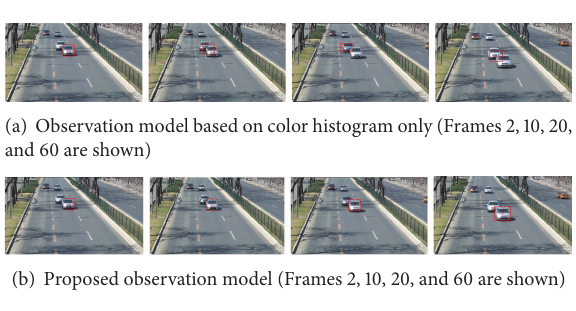
Figure 3: Tracking with different observations